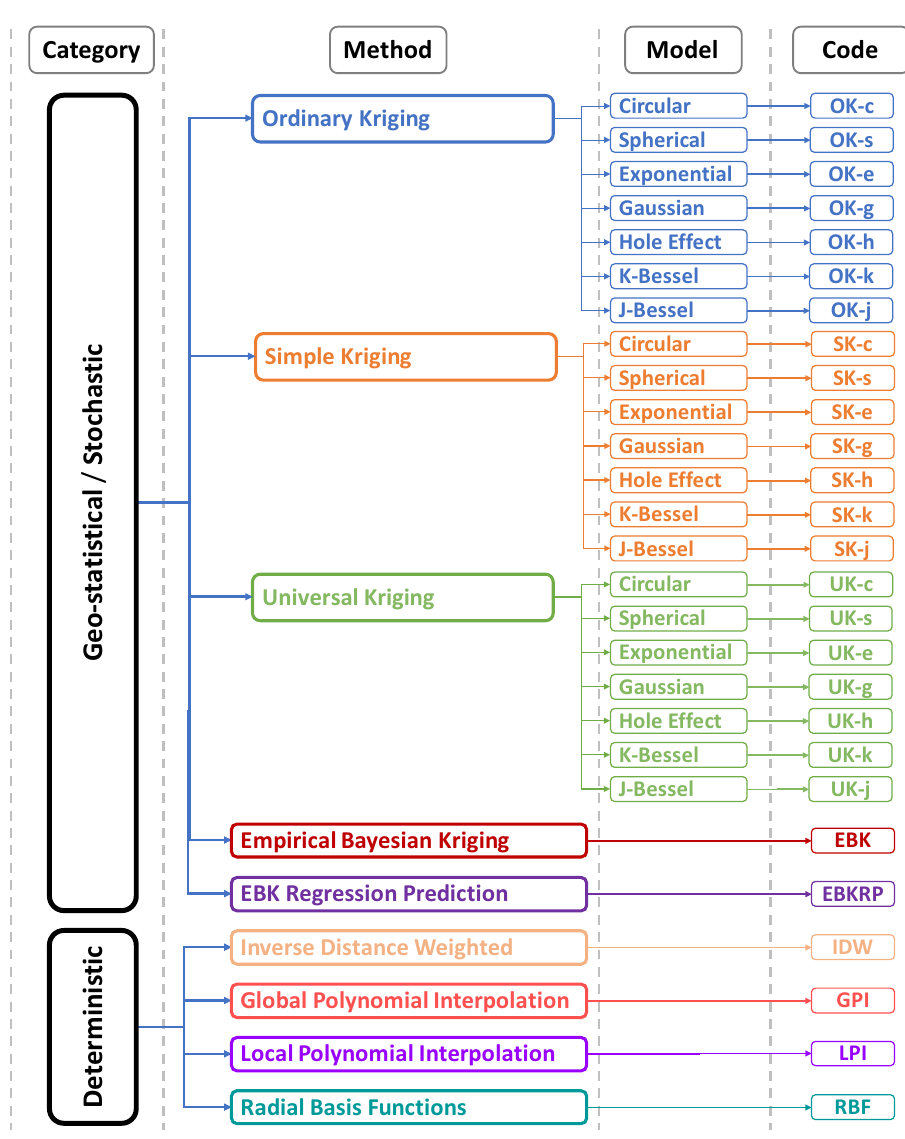
Figure 1. Schematic representation of different interpolation techniques selected for comparison. The schematic is designed by a co-author M.S. in Microsoft Visio (Version 2013), available at www. micro soft.